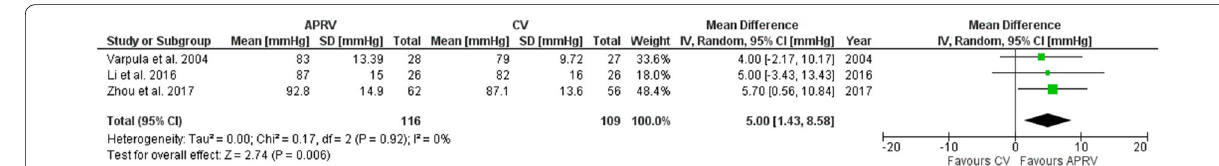
Fig. 6 MAP at day 3. APRV airway pressure release ventilation, CV conventional